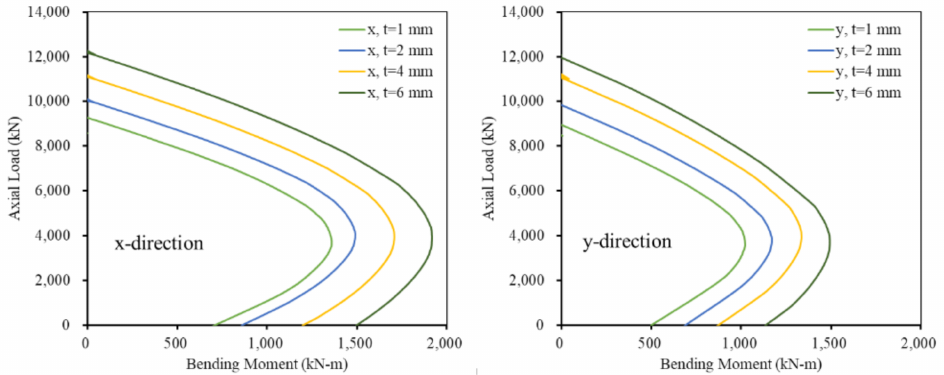
Figure 12. P-M interaction curves according to the inner tube thickness (rectangular